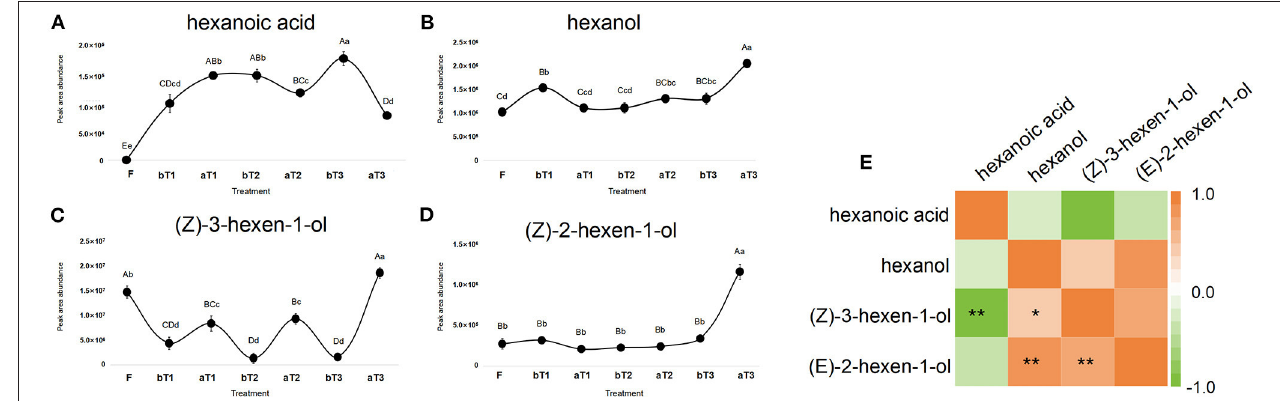
FIGURE 4 | Dynamic changes in C6 acid and C6 alcohols peak area abundance and correlation heat map during postharvest processing of oolong tea. (A–D) Dynamic changes of (A) hexanoic acid, (B) hexanol, (C) ( Z )-3-hexen-1-ol, and (D) ( Z )-2-hexen-1-ol. (E) Analysis of correlation heat map between C6 acid and C6 alcohols. F, fresh tea leaves; bT1–bT3, tea leaves before the three turnover treatments; aT1–aT3, tea leaves after the three turnover treatments. Different capital letters (A–D) and lowercase letters (a–d) represent significant differences at the p < 0.01 and p < 0.05 levels using Tukey’s test, respectively. One or two asterisks denote a statistically significant difference (* P < 0.05; ** P < 0.01) in relative amount between C6 acid and C6 alcohols during the turnover process of oolong